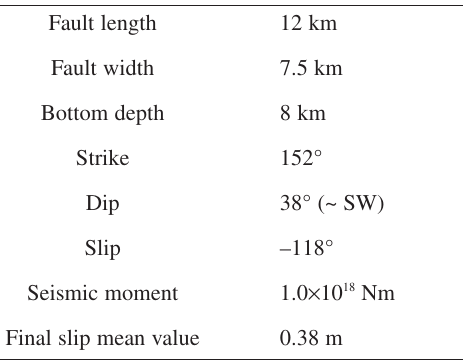
Table I. Parameters relative to the Colfiorito earth- quake (modified after Capuano et al. 2000).